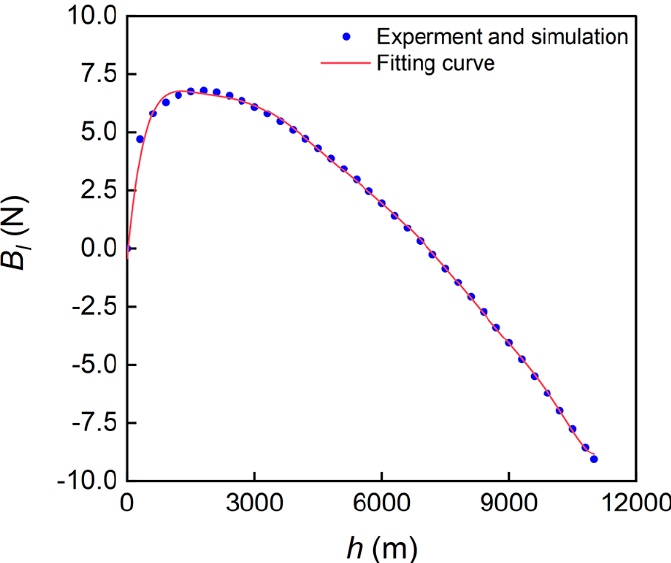
Figure 6. B l vs. h.